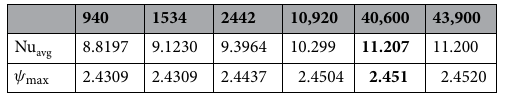
Table 2. Grid sensitivity check (Ha = 0, φ = 0.04, Da = 10 –2 , Ra = 10 5 ).